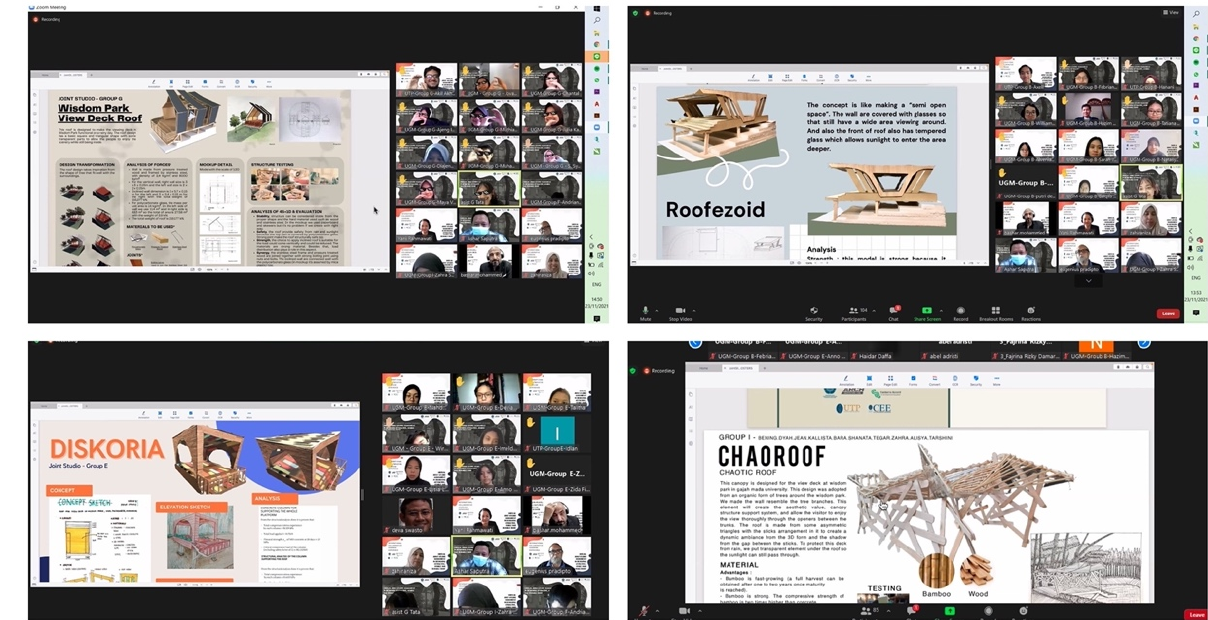
Figure 5. Photos of presentation and evaluation on day two. Table 8. Research findings and details of activities.